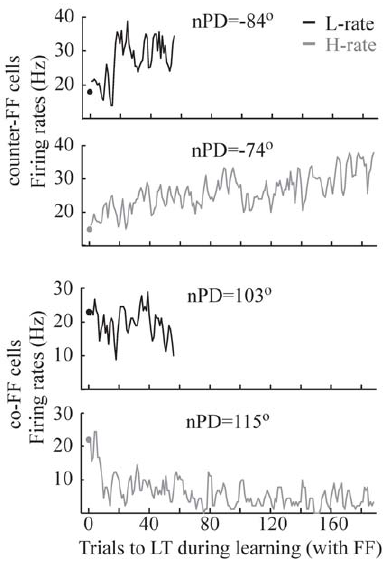
Figure 4. The activity of four different single cells in the L-rate condition (black) and H-rate condition (grey) on the first learning day as a function of trial number. The figure depicts (from top to bottom): a counter-FF cell recorded under the L-rate (nPD = 2 84 u ), a counter-FF cells recorded under the H-rate (nPD= 2 74 u ), a co-FF cell recorded under the L-rate (nPD=103 u ) and a co-FF cell recorded under the H-rate (nPD=115 u ). For each cell (trace) the figure shows average firing rate across standard trials to the learned target (circle) and firing rates along the learning trials to the learned